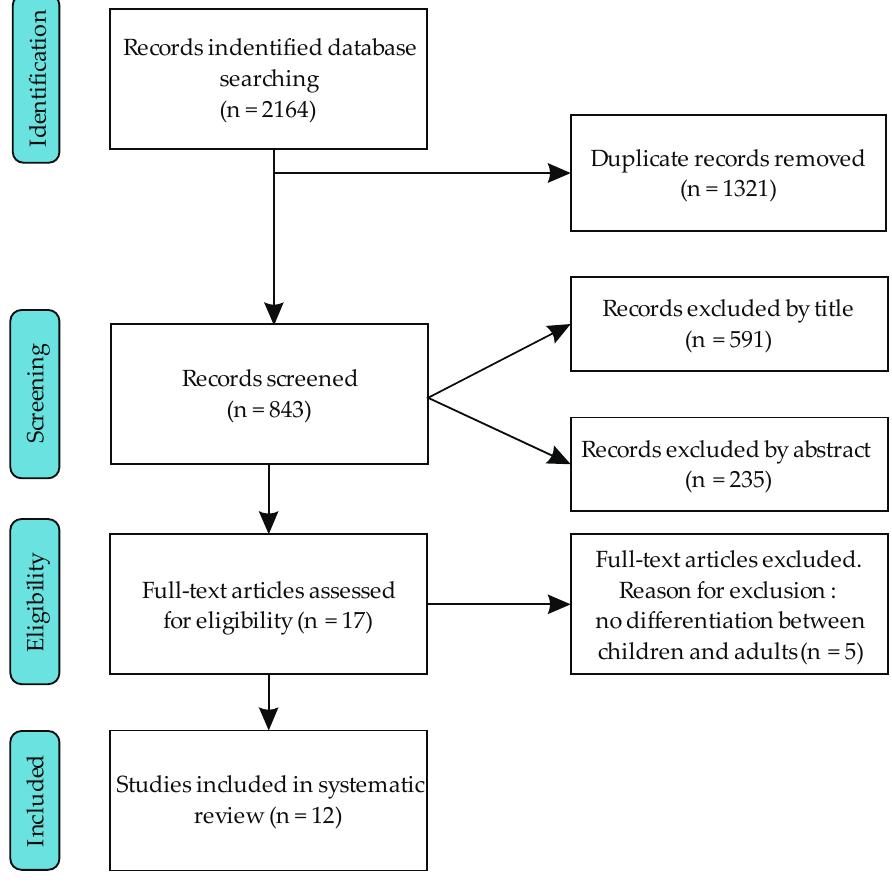
Figure 1. Selection of articles.